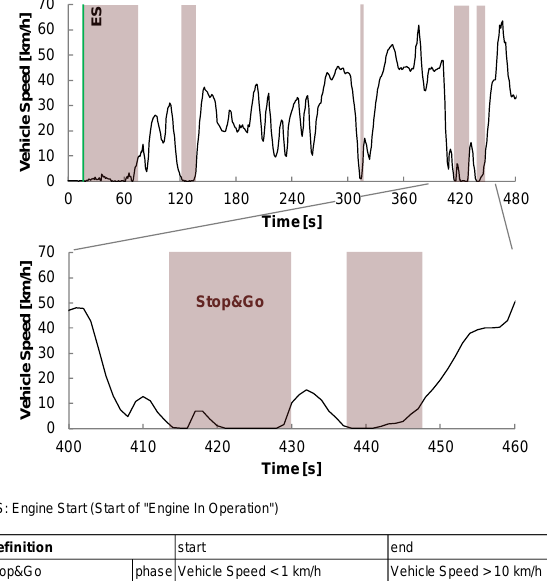
Fig. 3. Definition of stop&go in RDE-test